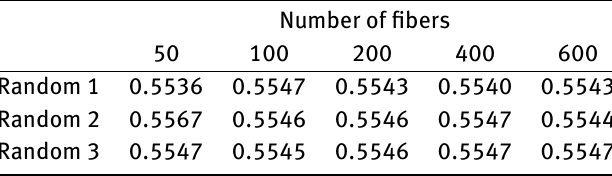
Table 2: Influence of random distributions of fibers on the effective thermal conductivity of composites with v f = 27%